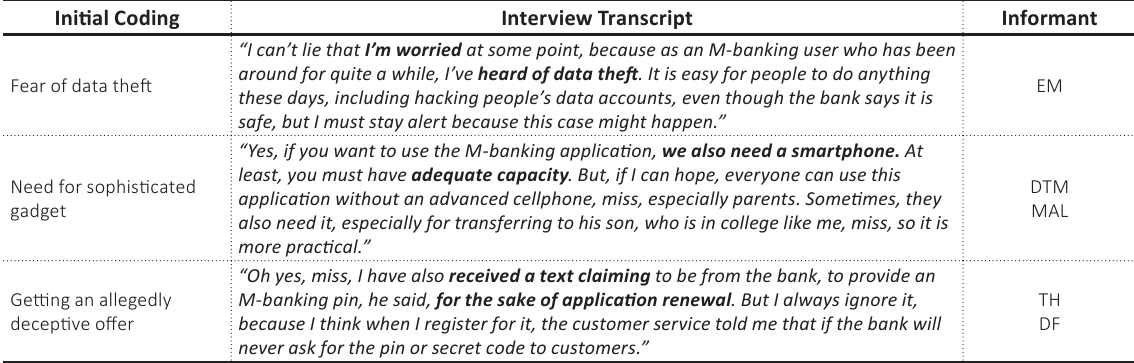
Table 3. Coding a negative impact based on interview